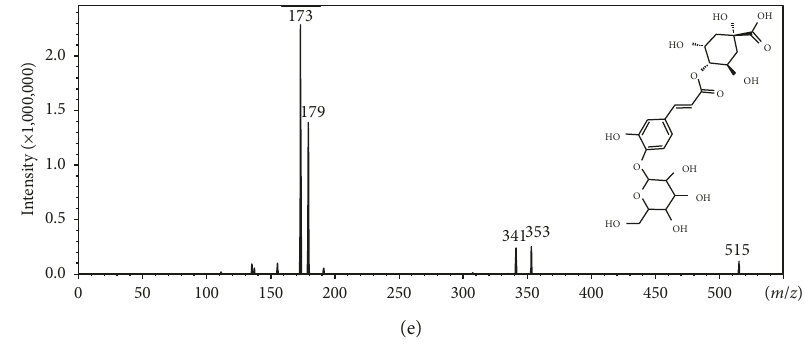
Figure 3: Product ion spectra and fragmentation pathway of diCQA positional isomers: (a) 3,4-diCQA, (b) 3,5-diCQA, and (c) 4,5-diCQA detected in Bidens pilosa plant extracts. Product ion spectra and fragmentation pathway of CQA glycoside positional isomers: (d) 3- O -(4 ′ - O - caffeoyl glucosyl) quinic acid and (e) 4- O -(4 ′ - O -caffeoyl glucosyl) quinic acid detected in Moringa oleifera plant